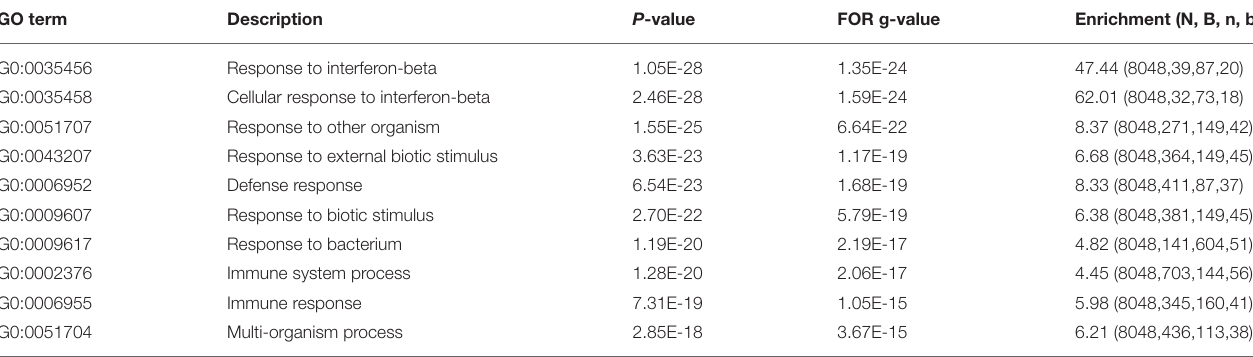
TABLE 1 | Compilation of the first top 10 pathways that were changed in murine keratinocytes upon co-culture with pre-activated CD8 + T cells for 1 d. GO